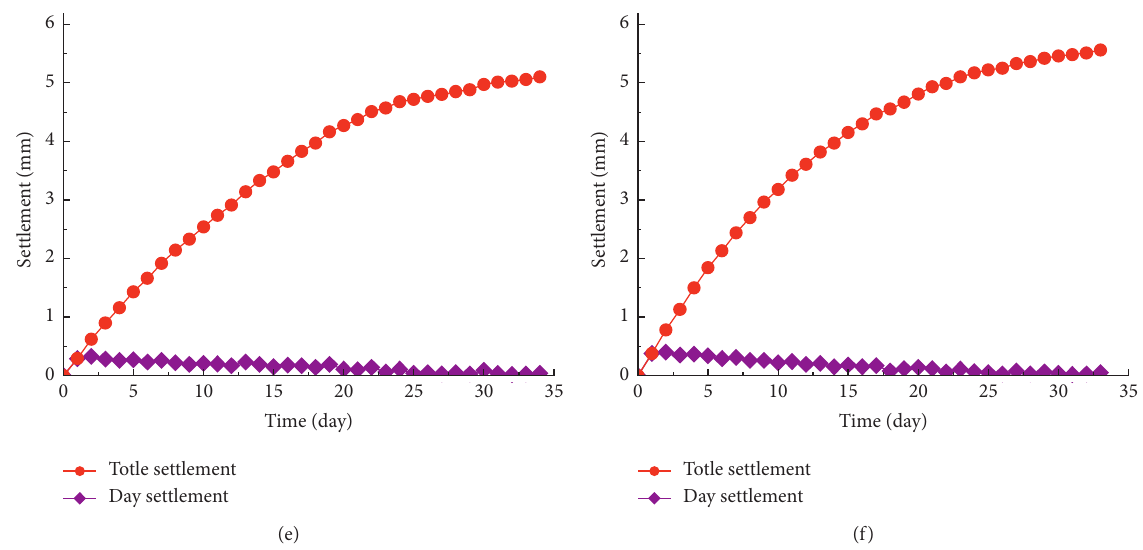
Figure 8: Settlement monitoring of the six monitoring points with daily and cumulative deformation. (a) Monitoring point 1. (b) Monitoring point 2. (c) Monitoring point 3. (d) Monitoring point 4. (e) Monitoring point 5. (f) Monitoring point